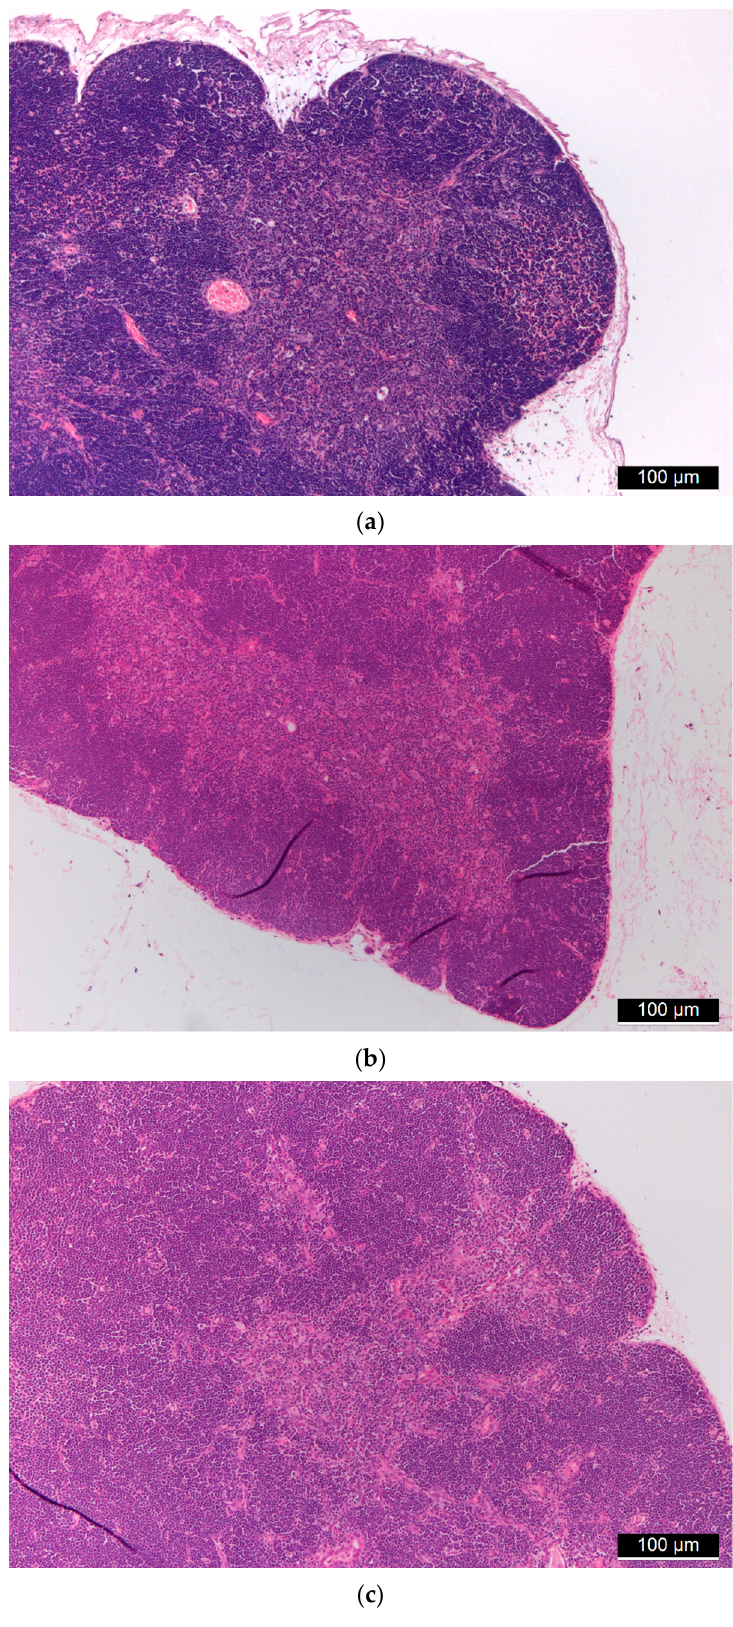
Figure 5. ( a ) Control thymus tissue. ( b , c ): Thymus tissues of “low dose” ( b ) and “high dose” ( c ) FSGM-treated mice.